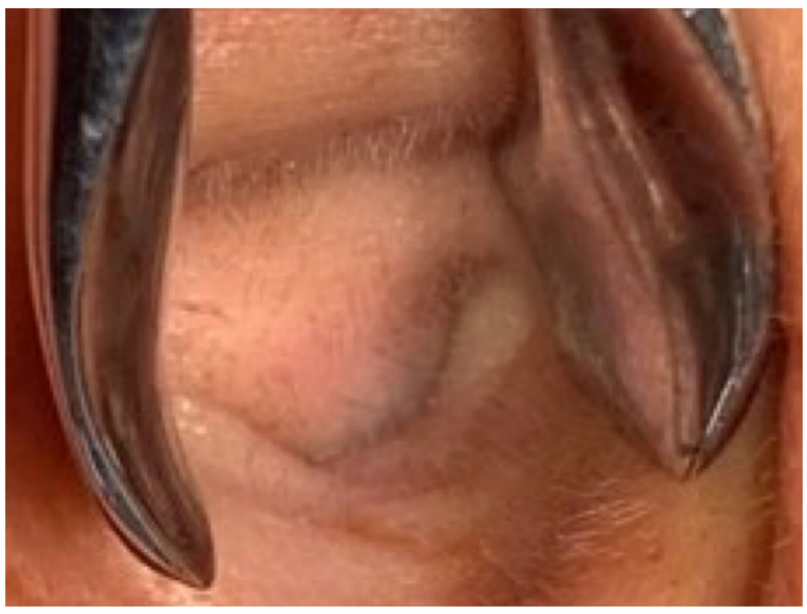
Figure 1. Otoscopy revealed a smooth, subcutaneous bulging mass that totally occluded the external auditory canal (EAC).